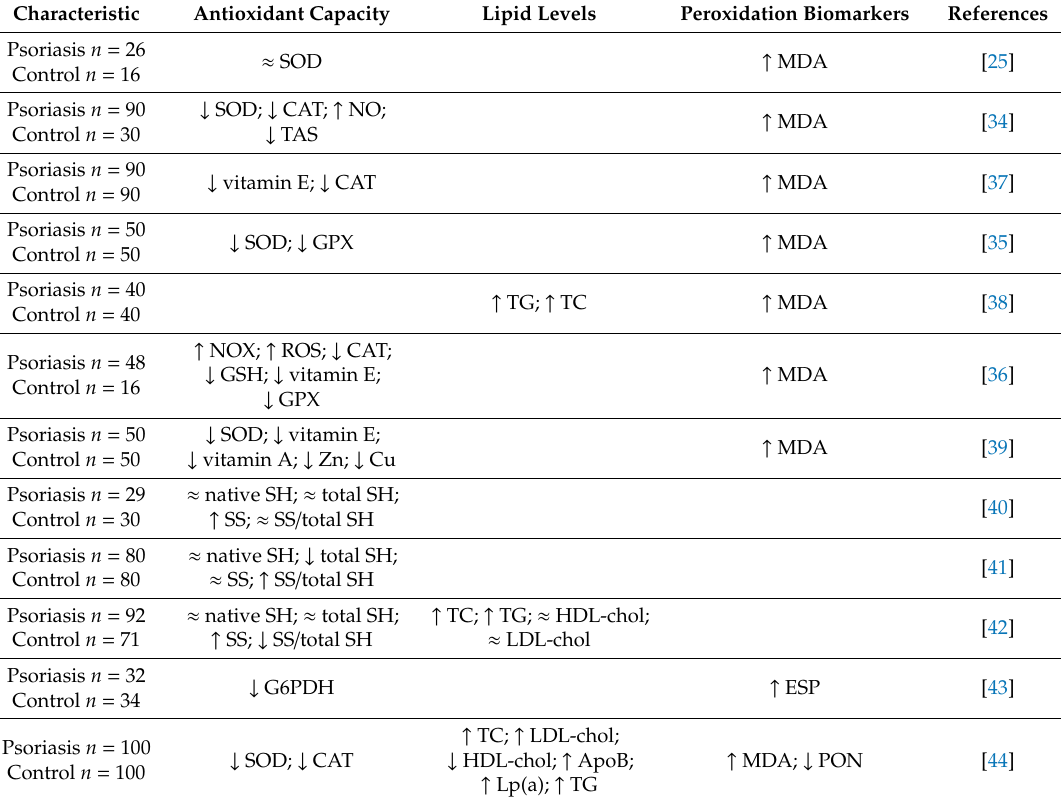
Table 1. Plasma antioxidant capacity and lipid peroxidation biomarkers in